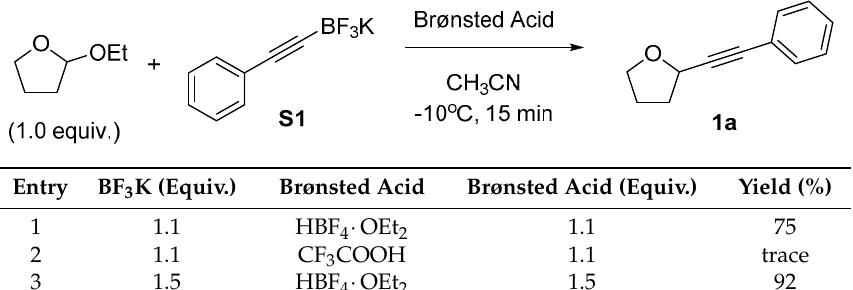
Table 1. Optimization of conditions for the synthesis of tetrahydrofuran 1a .